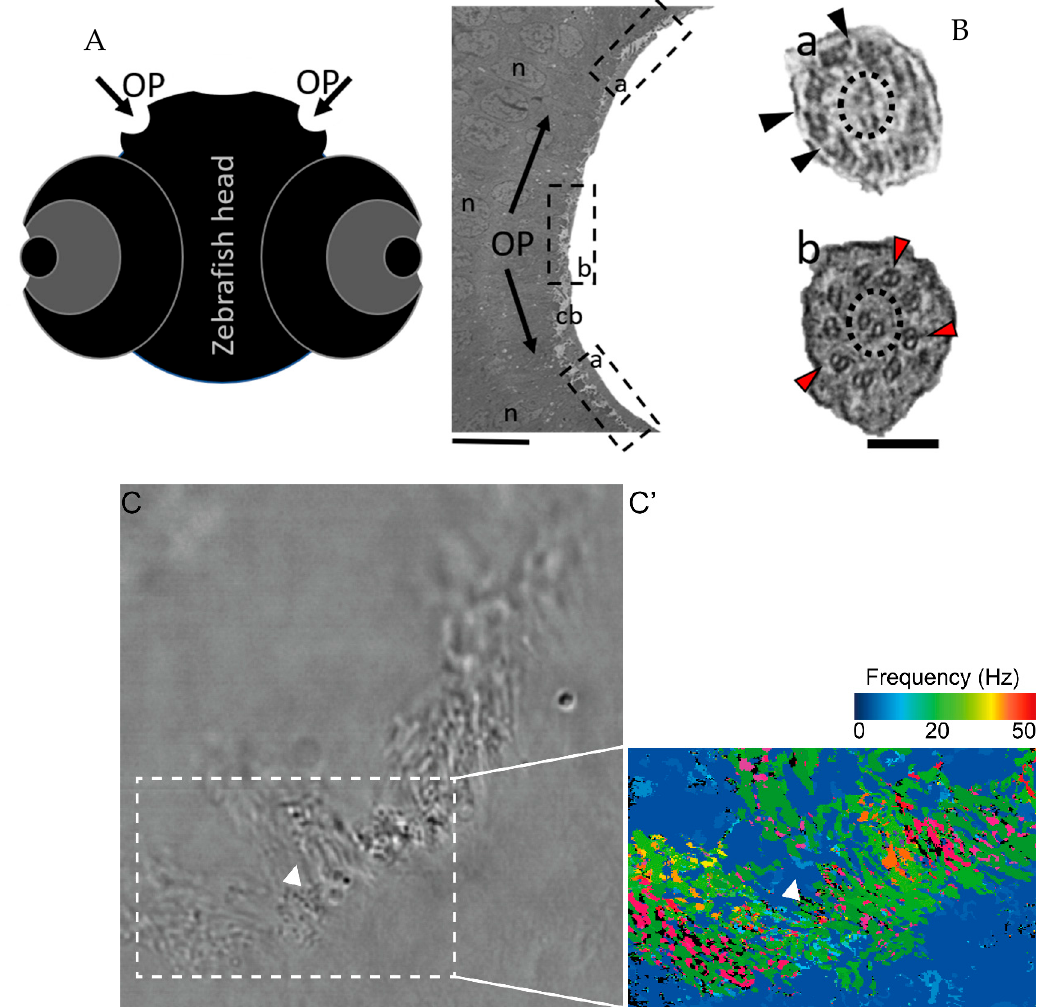
Figure 4. The zebrafish OP has two different types of cilia . ( A ) Schematic representation of 5 dpf zebrafish head, structures of interest are marked with arrows—olfactory pits (OP). ( B ) TEM low magnification image showing a cross-section across an OP of a WT zebrafish, a bowl-shaped structure containing multiciliated cells and cilia in several orientations. In the periphery of this pit (dotted boxes a and inset), cilia containing classical motile structure 9+2 with dynein arms (black arrowheads). In the most internal region of the OP (dotted box b and inset) we detected cilia with 9+2 ultrastructural arrangement without dynein arms (red arrowheads); this pattern was visible in WT embryos (n=3). ( C ) Snapshot from a movie of beating OP cilia and respective heatmap by software CiliarMove ( C’ ), highlighting a region of immotile cilia (arrowhead) that was coincident with the region detected by TEM in B. n—nucleus; cb—cilia border; OP—olfactory pit. Thin bar 6 µ m, thick bar 100